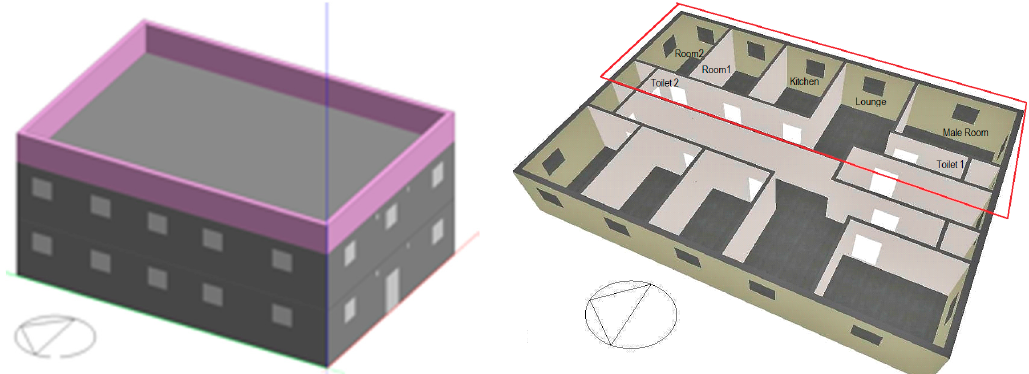
Figure 8. The plan and geometric description of the